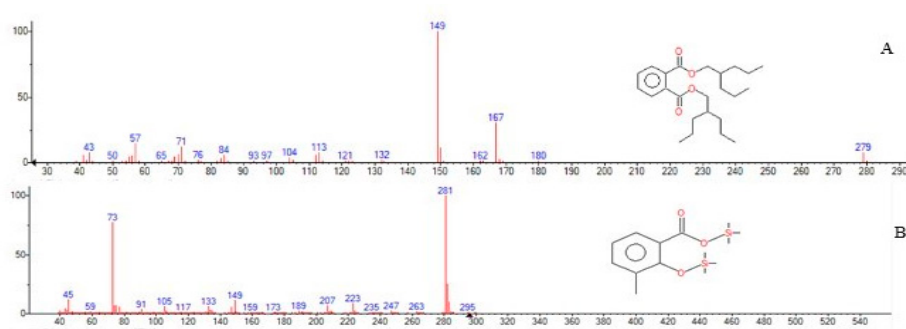
Figure 4. Depicting the GC-MS intermediates of phenanthrene degradation. The indicated frag- mentation pattern shows ( A ) phthalic acid, di(2-propylpentyl) ester; ( B ) 3-methylsalicylic acid, 2TMS derivative.